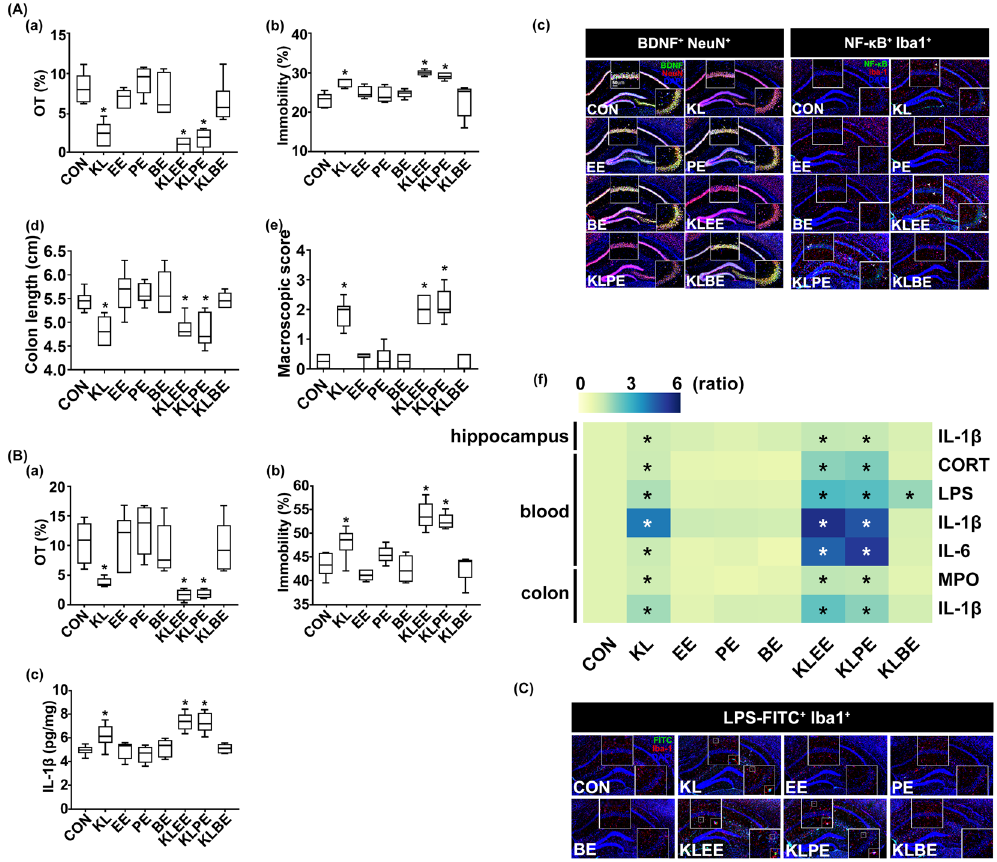
Figure 6. Effects of gut bacteria EPS and LPS on the occurrence of anxiety/depression and colitis in mice. ( A ) Effects of orally gavaged EPS and/or LPS. Effects on the occurrence of anxiety/depression in the EPMT (a) and TST (b). Effects on the BDNF + /NeuN + and NF-κB + /Iba1 + cell population in the hippocampus (c). Effects on colon length (d) and macroscopic score (e). (f) Effects on the IL-1β, IL-6, LPS, MPO, and corticosterone levels, indicated as compared to control group (CON: 1). Heatmap was generated using Plotly (https:// chart- studio. plotly. com). ( B ) Effects of intraperitoneally injected EPS and/or LPS on the occurrence of anxiety/ depression in the EPMT (a) and TST (b) and expression of IL-1β in the hippocampus (c). ( C ) Effects of EPSs on the translocation of FITC-conjugated LPS into the brain. Test agents (CON, vehicle [saline]; EE, 20 μg/ kg (i.p.) or 20 mg/kg (p.o.) of Enterococcus faecium exopolysaccharide; PE, 20 μg/kg (i.p.) or 20 mg/kg (p.o.) of Pediococcus acidilactici exopolysaccharide; BE, 20 μg/kg (i.p.) or 20 mg/kg (p.o.) of Bifidobacterium longum exopolysaccharide; KL, 20 μg/kg (i.p.) or 20 mg/kg (p.o.) of Klebsiella oxytoca lipopolysaccharide ; KLEE, 20 μg/ kg (i.p.) or 20 mg/kg (p.o.) of Ko and Ef (1:1); KLPE, 20 μg/kg (i.p.) or 20 mg/kg (p.o.) of Ko and Pa (1:1); KLBE, 20 μg/kg (i.p.) or 20 mg/kg (p.o.) of Ko and Bl (1:1) were treated in mice once a day for 5 days. FITC-conjugated LPS was orally gavagaed daily for 2 days from 24 h after EPS or LPS conjugated without FITC was gavaged for 3 days. Control mice were treated with vehicle (saline) instead of gut bacterial suspension. Data are shown as box plots (n = 8). *p < 0.05 vs Con. All were analyzed using unpaired t